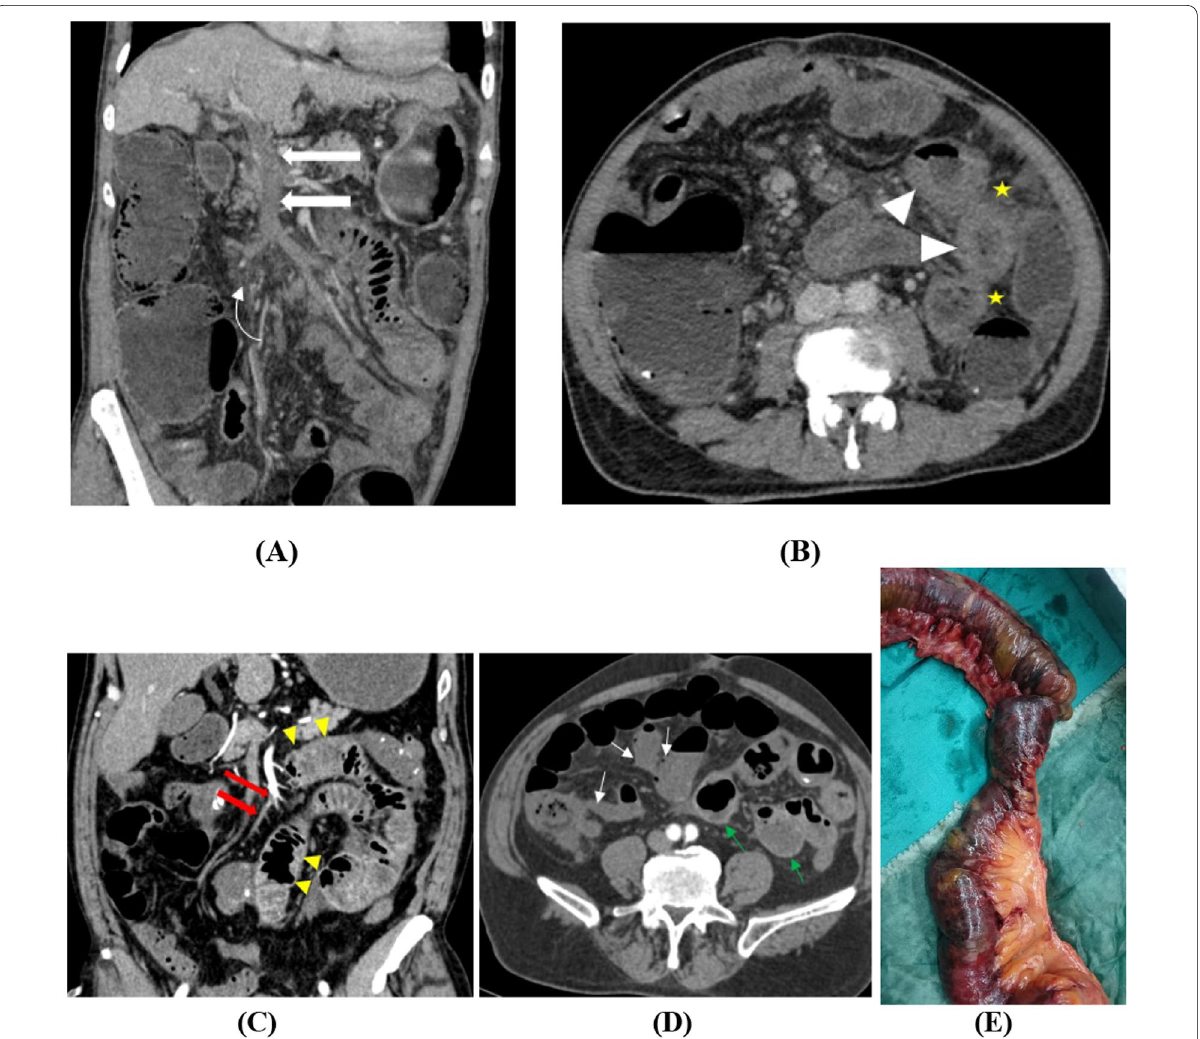
Fig. 5 A , B For a 64-year-old male patient diagnosed with superior mesenteric vein occlusion. C – E For a 72-year-old male patient diagnosed with superior mesenteric artery occlusion. A Coronal oblique CT in venous phase showing complete occlusion of the superior mesenteric and portal veins (white arrows) as well as fat stranding around the mesenteric vein (curved white arrow). B Axial CT in venous phase showing mural thickening (white arrow heads) with preserved mural enhancement associated with mild surrounding fat stranding (yellow star). C Coronal CT in arterial phase showing filling defect at the superior mesenteric artery and one of its branches (red arrows) with dilated small bowel loops (yellow arrow heads). D Axial CT in arterial phase showing mural hypo-enhancement of ileal bowel loops (white arrows) compared to normal enhancement of the jejunal loops (green arrows). E Image of resected ischemic bowel loop that approve the CT diagnosis of bowel